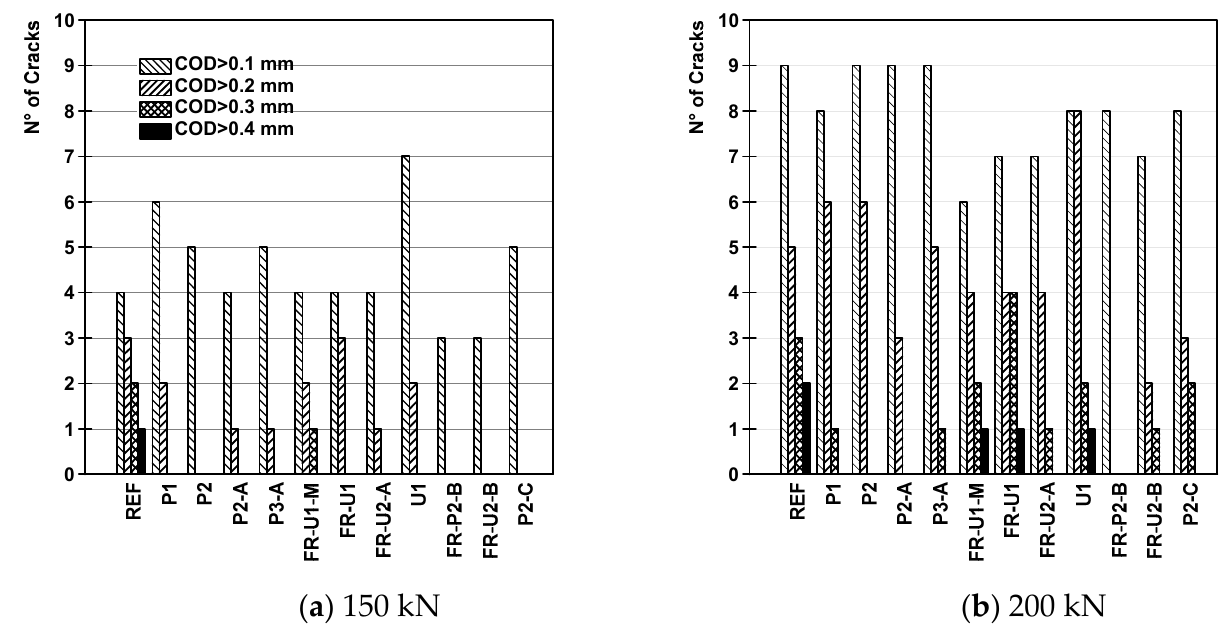
Figure 9. N° of cracks at reference loads. Figure 9. N ◦ of cracks at reference